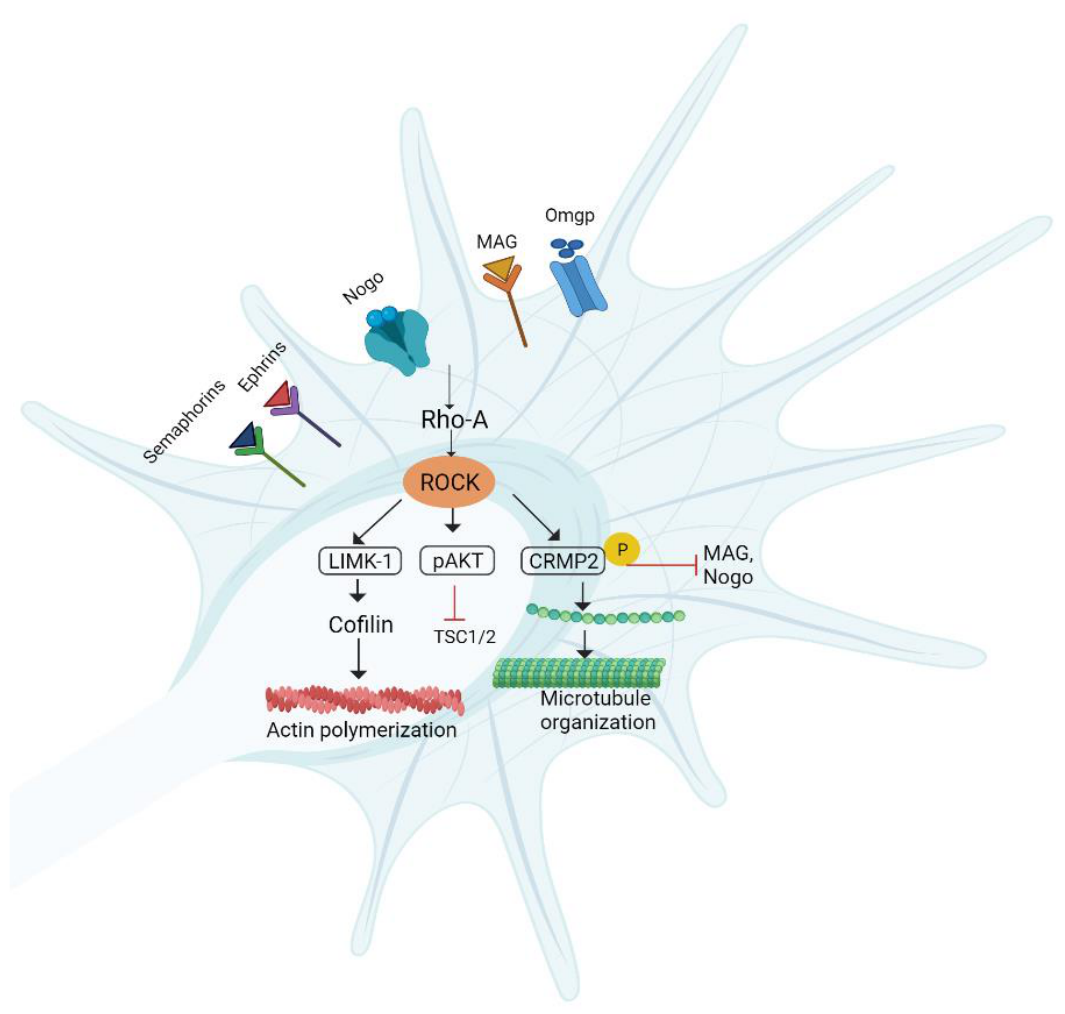
Figure 12. RhoA/ROCK/LIMK pathway. Different myelin inhibitors activate RhoA and Rho-associated kinases (ROCK), which in turn activate LIMK-1, cofilin, CRMP2, and AKT to control axonal development. RhoA and ROCK inactivation enhances cytoskeletal actin filament formation and prevents axonal degeneration to boost growth cone stability. TSC1/2 (hamartin–tuberin); AKT: protein kinase B; MAG: myelin-associated glycoproteins; Omgp: oligodendrocyte myelin glycoprotein; CRMP2: collapsin response mediator protein 2; LIMK: LIM domain kinase.